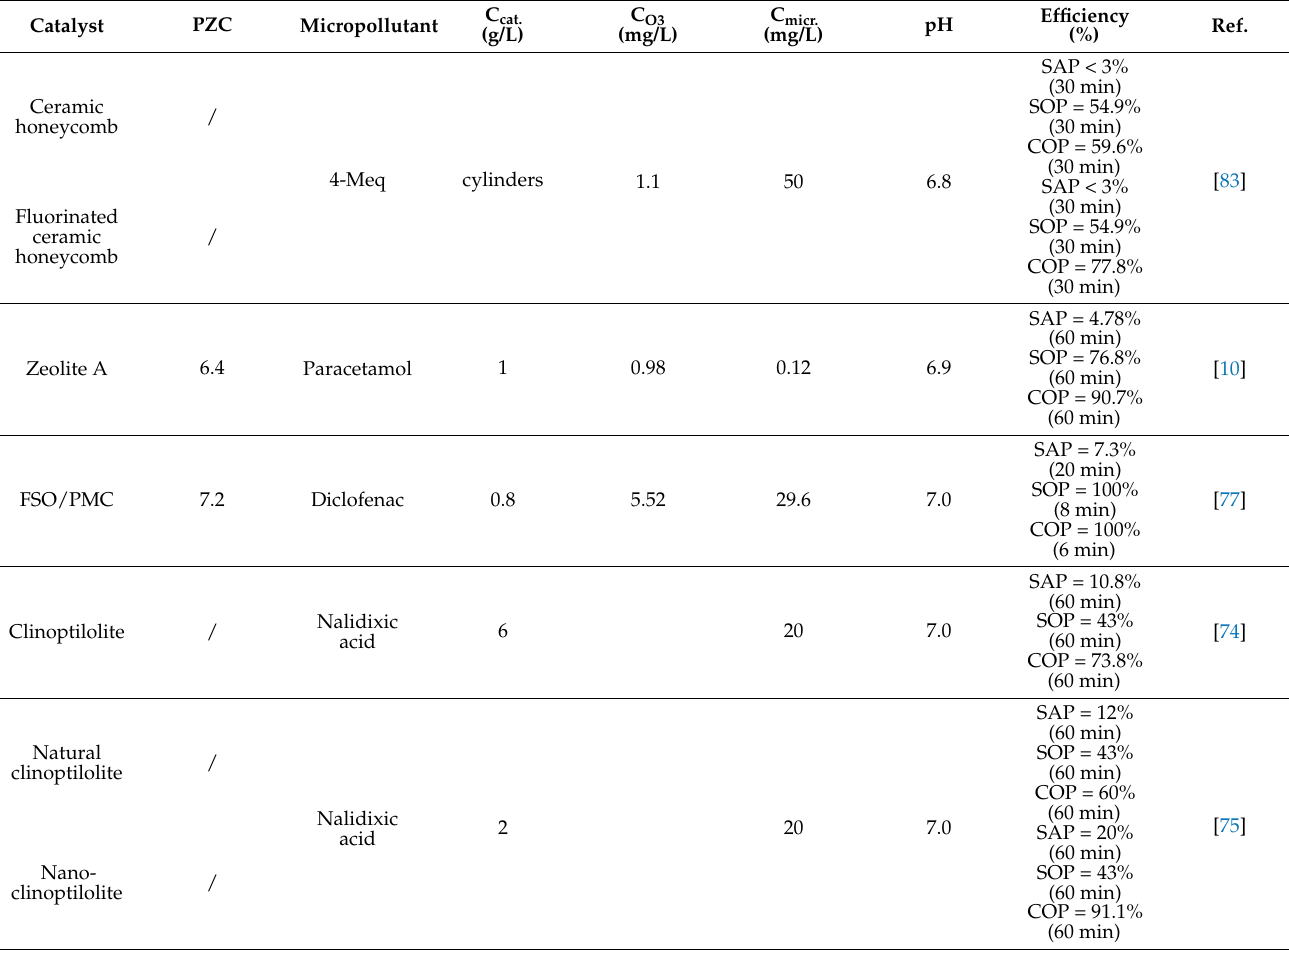
Table 3. Minerals used as catalysts in the heterogeneous catalytic ozonation process at the pH range